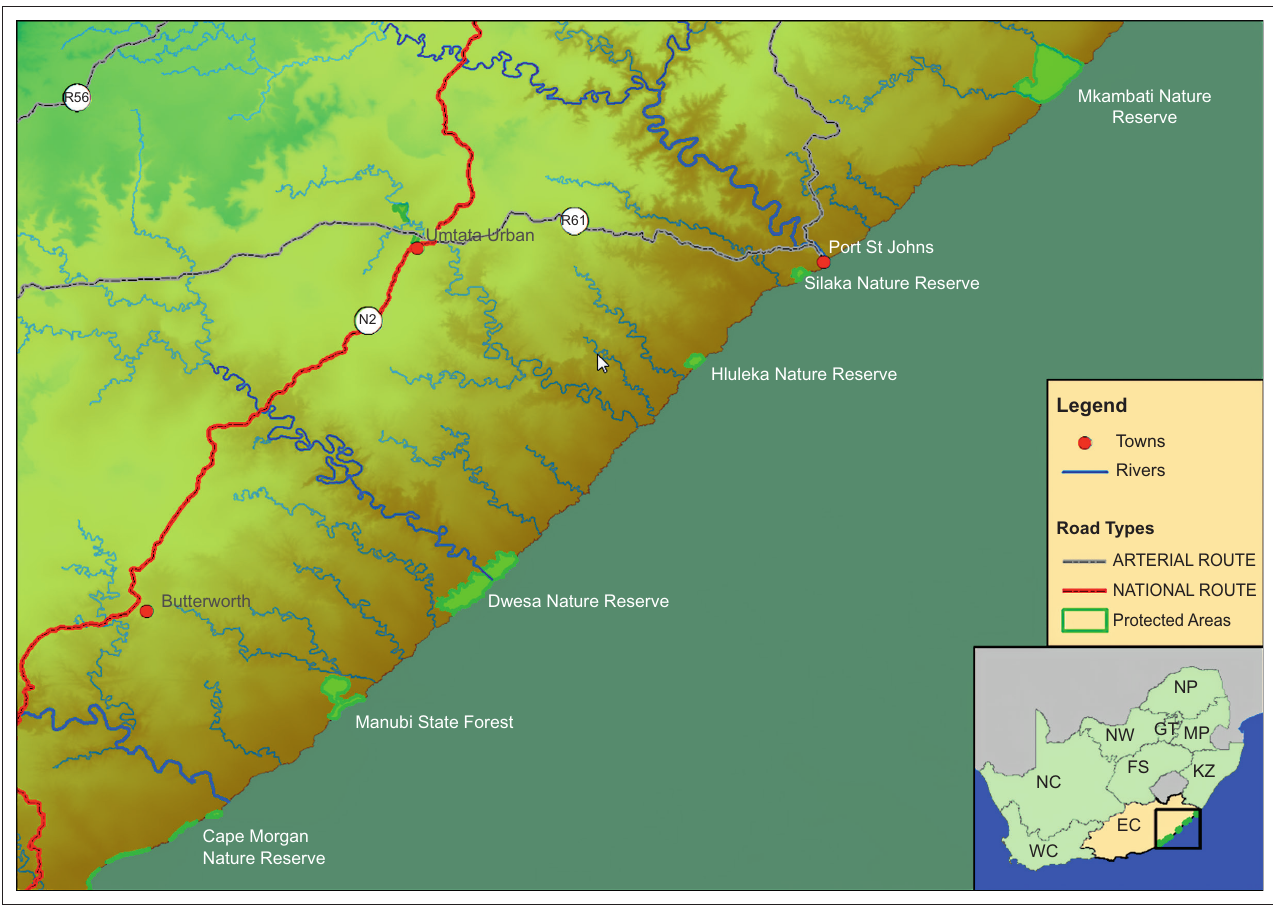
FIGURE 1: The location of the six protected areas along the Wild Coast, Eastern Cape, South Africa, where reptile and amphibian surveys were